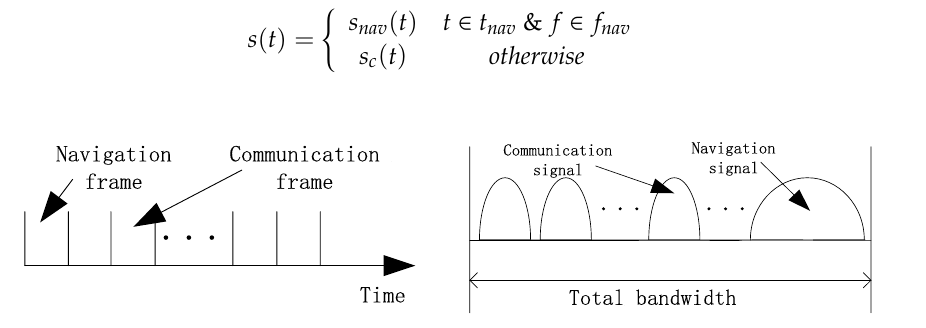
Figure 2. Time domain and PSD of signal generated by method 2.